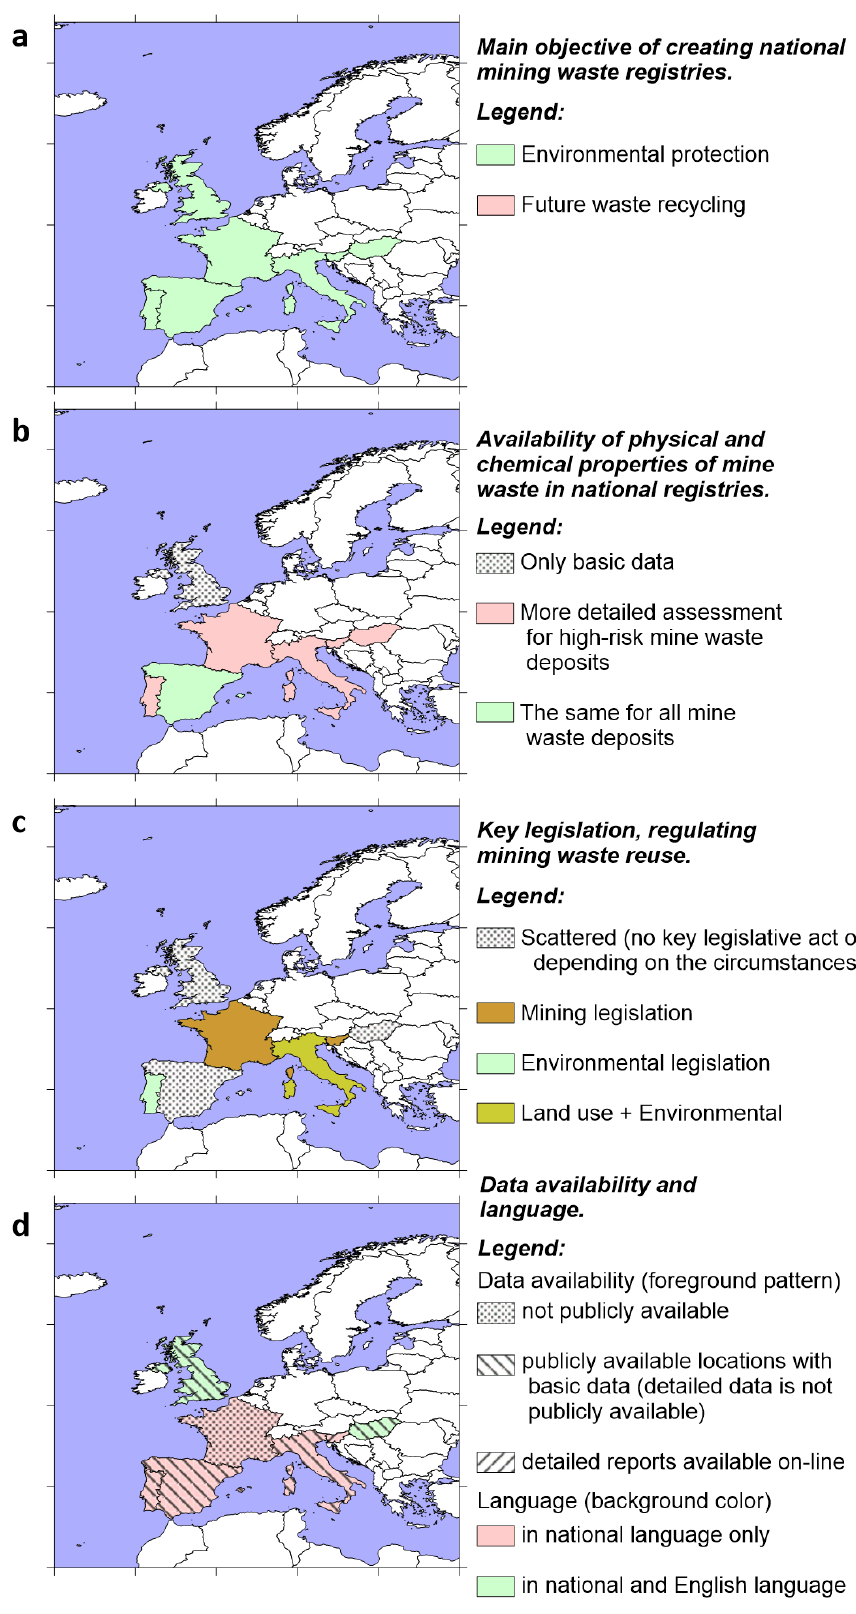
Figure 3. ( a ) The main country vision for creating national mine waste registries. ( b ) Availability of detailed mine waste deposit data. ( c ) Key legislation which regulates resource recovery from mine waste (simplification). ( d ) Data availability and language used in national mine waste